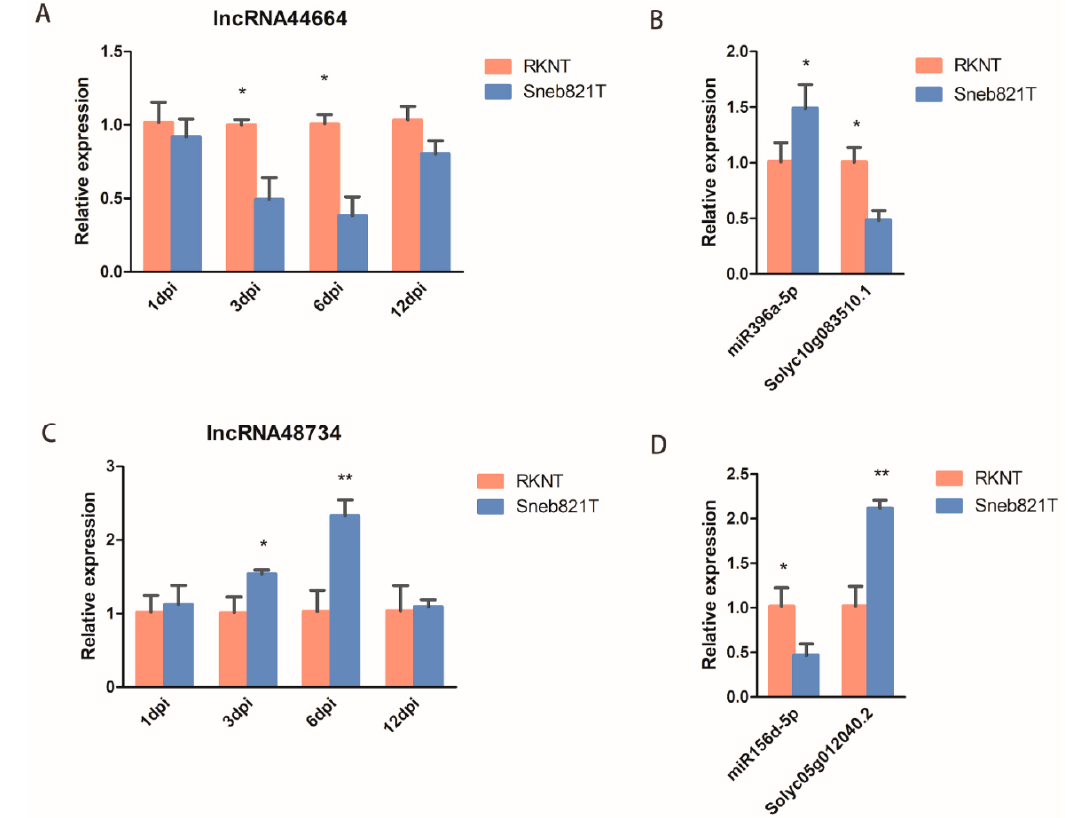
Figure 5. Verification of di ff erentially expressed lncRNAs by qRT-PCR. ( A ) qRT-PCR analysis of lncRNA44664 in tomato plants. ( B ) qRT-PCR analysis of miR396a and the target genes in tomato plants. ( C ) qRT-PCR analysis of lncRNA48734 in tomato plants. ( D ) qRT-PCR analysis of miR156d and